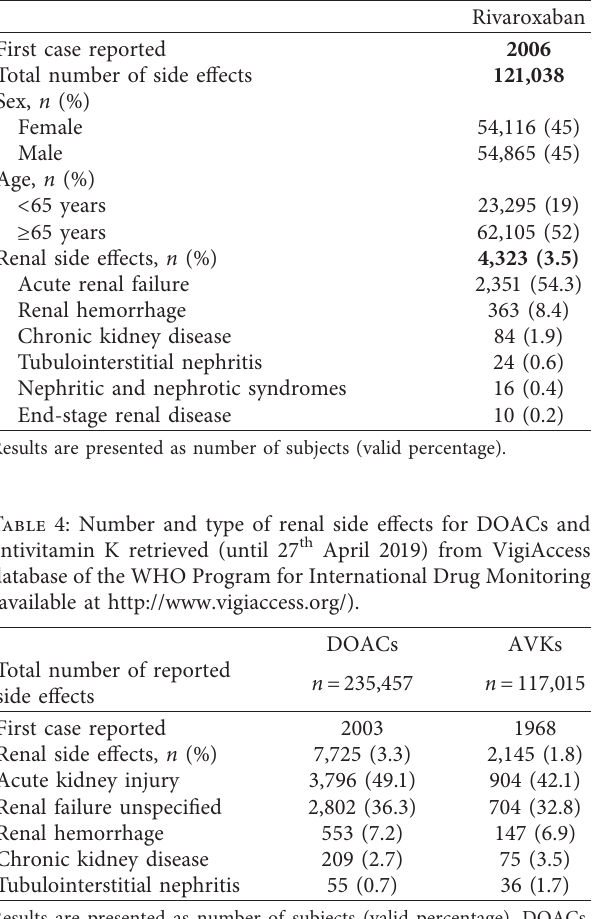
rivaroxaban, apixaban, edoxaban, and dabigatran. Acenocoumarol, war- farin, and phenprocoumone were regrouped as